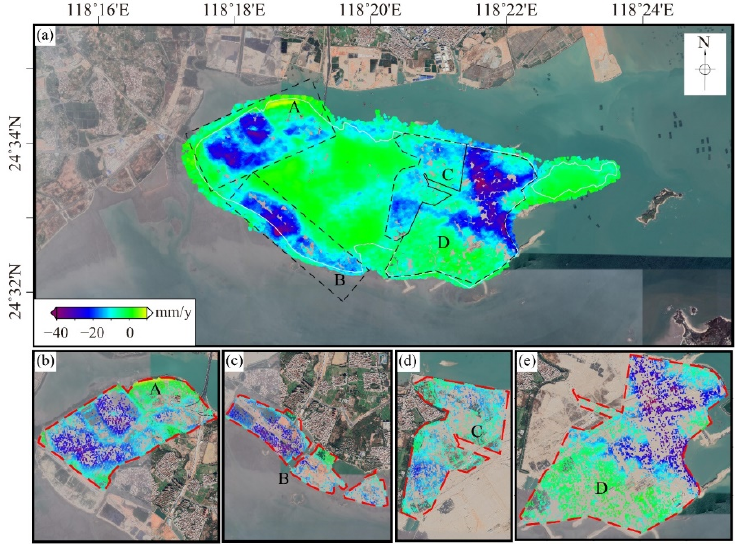
Figure 3. Average deformation rate map of the study area. Positive values denote the deformation toward the satellite. Negative values denote the deformation away from the satellite: ( a ) average deformation rate map of the whole study area; ( b – e ) enlarged view of areas outlined by dotted lines in ( a ).